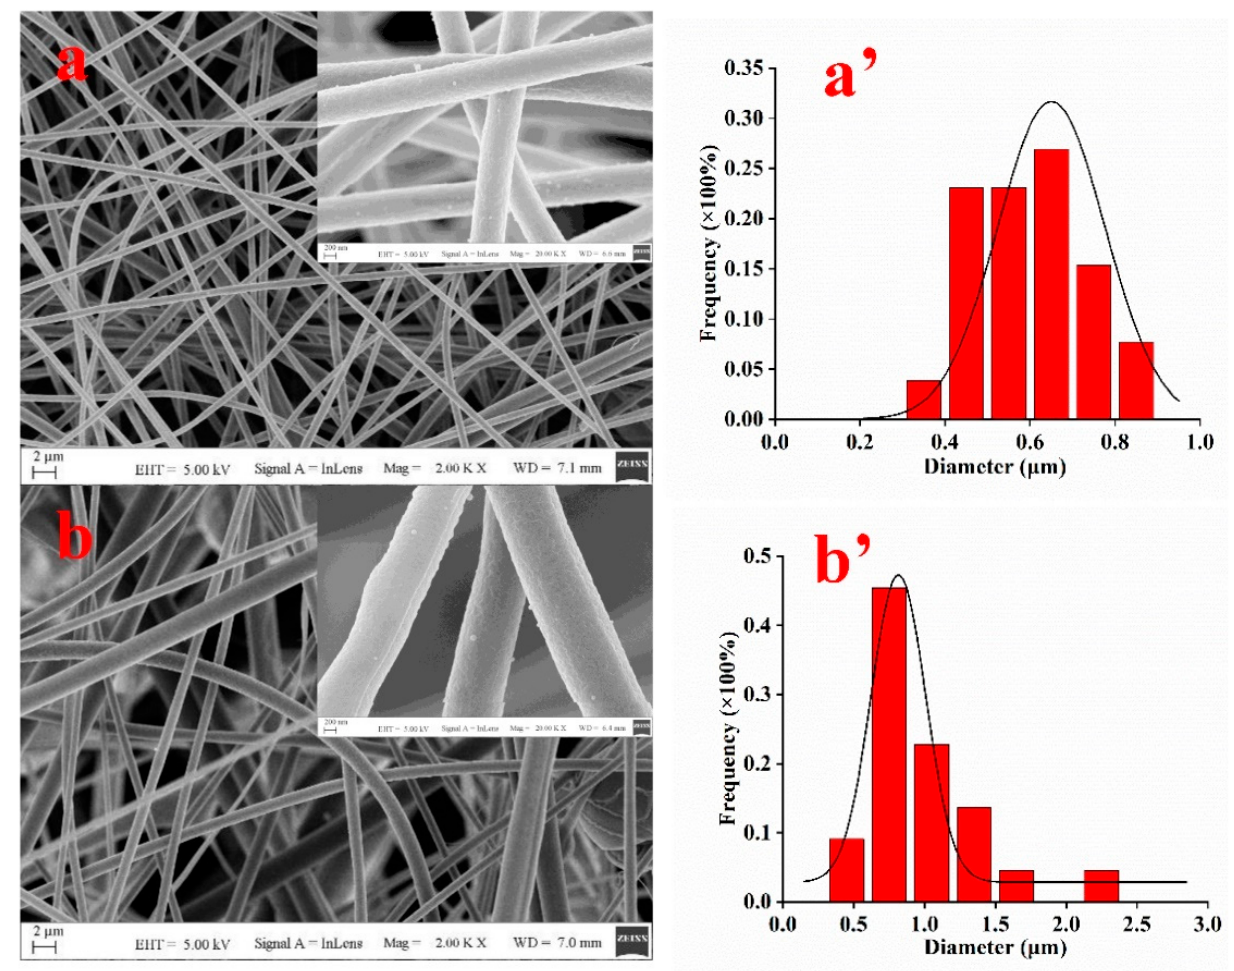
Figure 2. The SEM images of ( a ) PAN nanofibers and ( b ) PAN-PS nanofibers and the size distributions of ( a’ ) PAN nanofibers and ( b’ ) PAN-PS nanofibers.